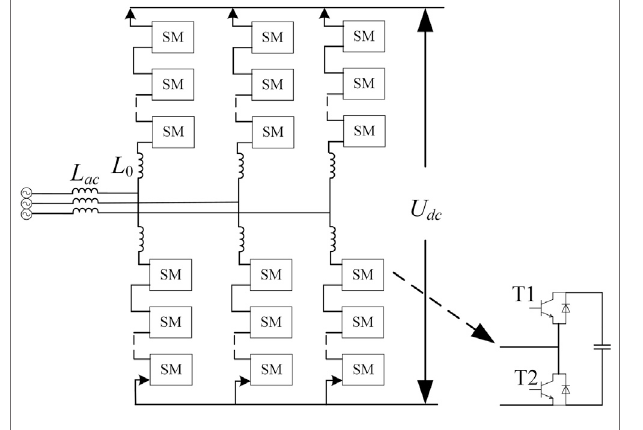
FIGURE 1 | The topology of MMC.